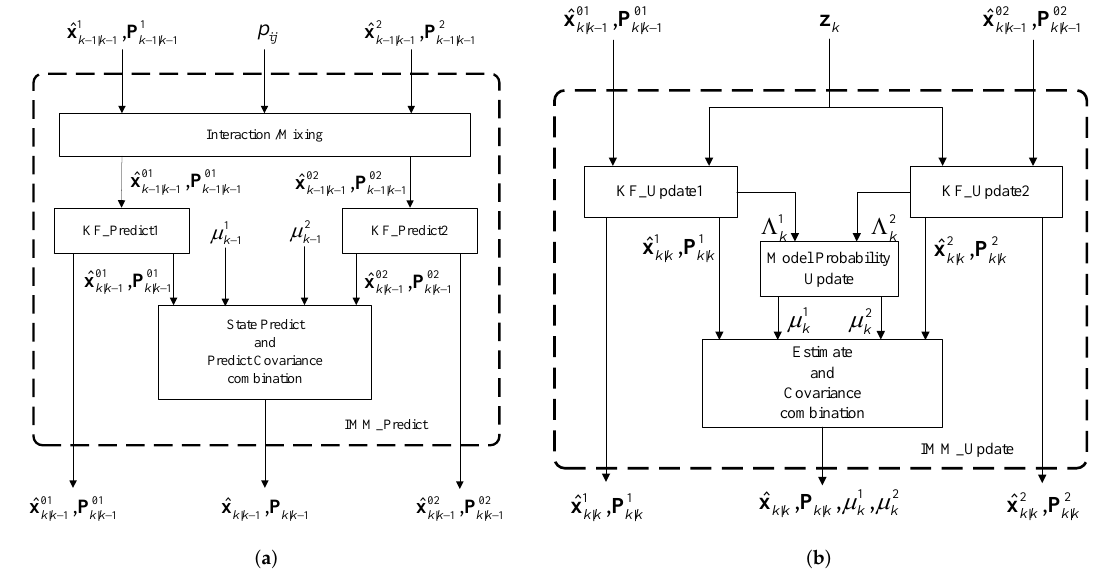
Figure 3. ( a ) Flowchart for Interacting Multiple Model (IMM)-predict; ( b ) Flowchart for